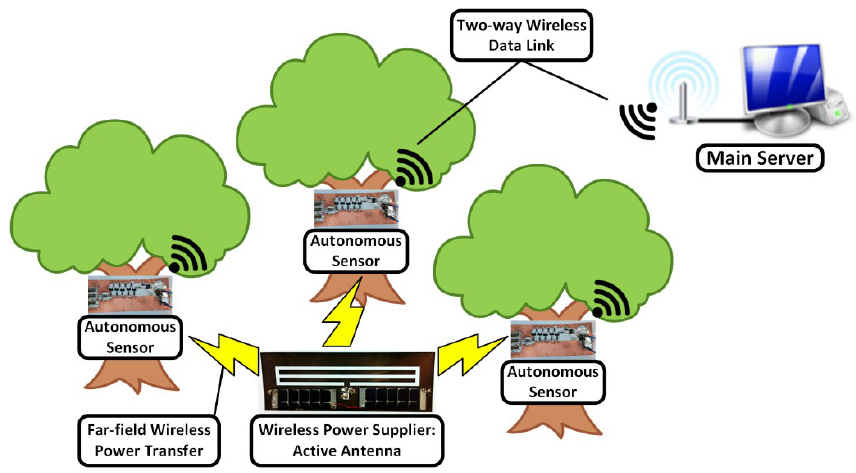
Figure 1. Application scenario of self-sustainable autonomous sensor system.